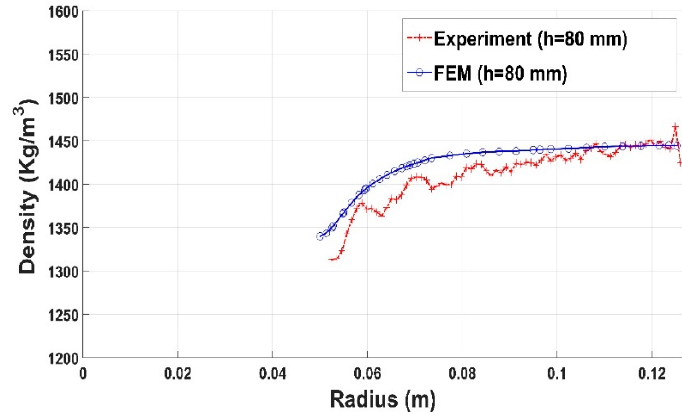
Figure 28. Density profile along the radius (stub hole): experiment vs. finite element result (h = 80 mm).